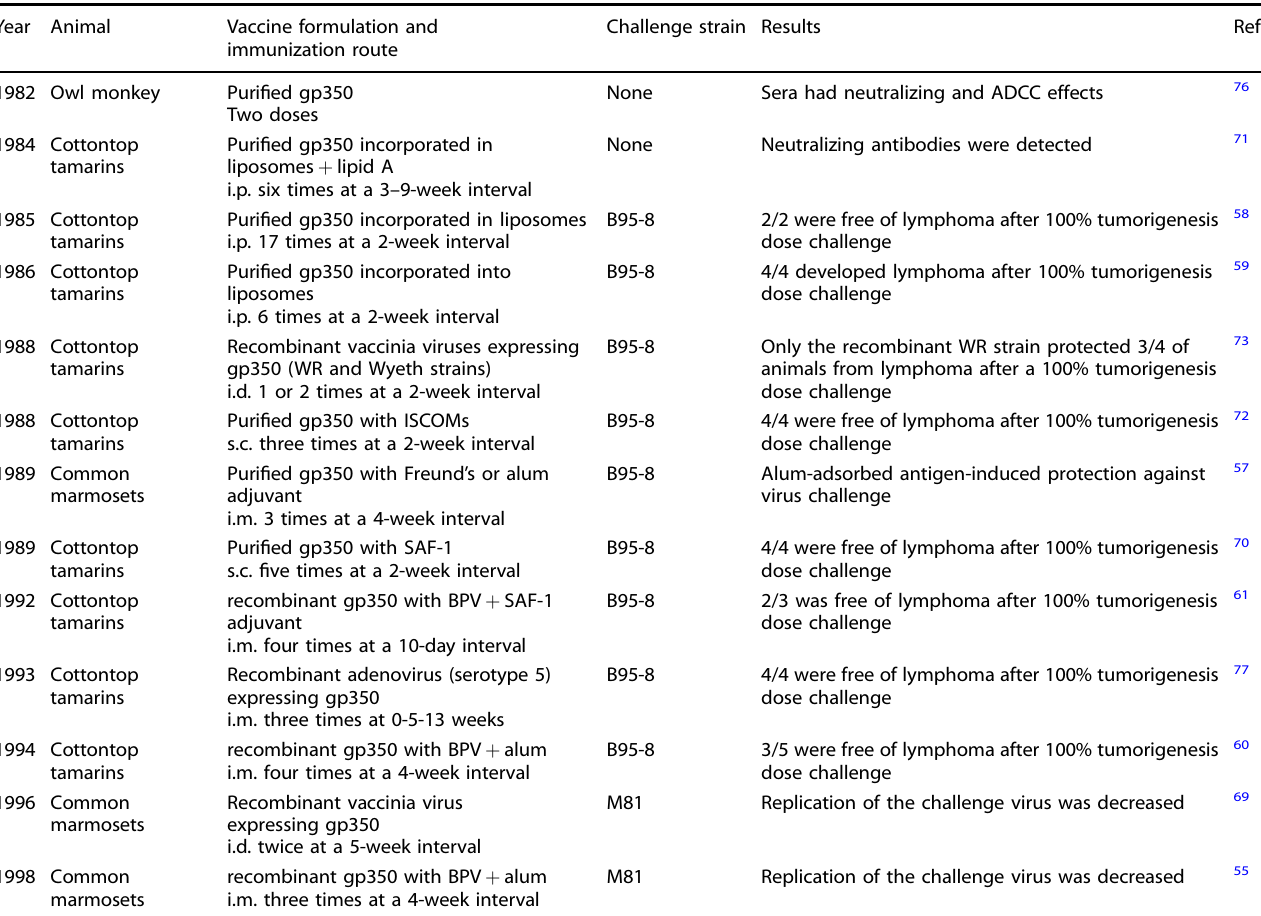
Table 4. Nonhuman primate models for EBV